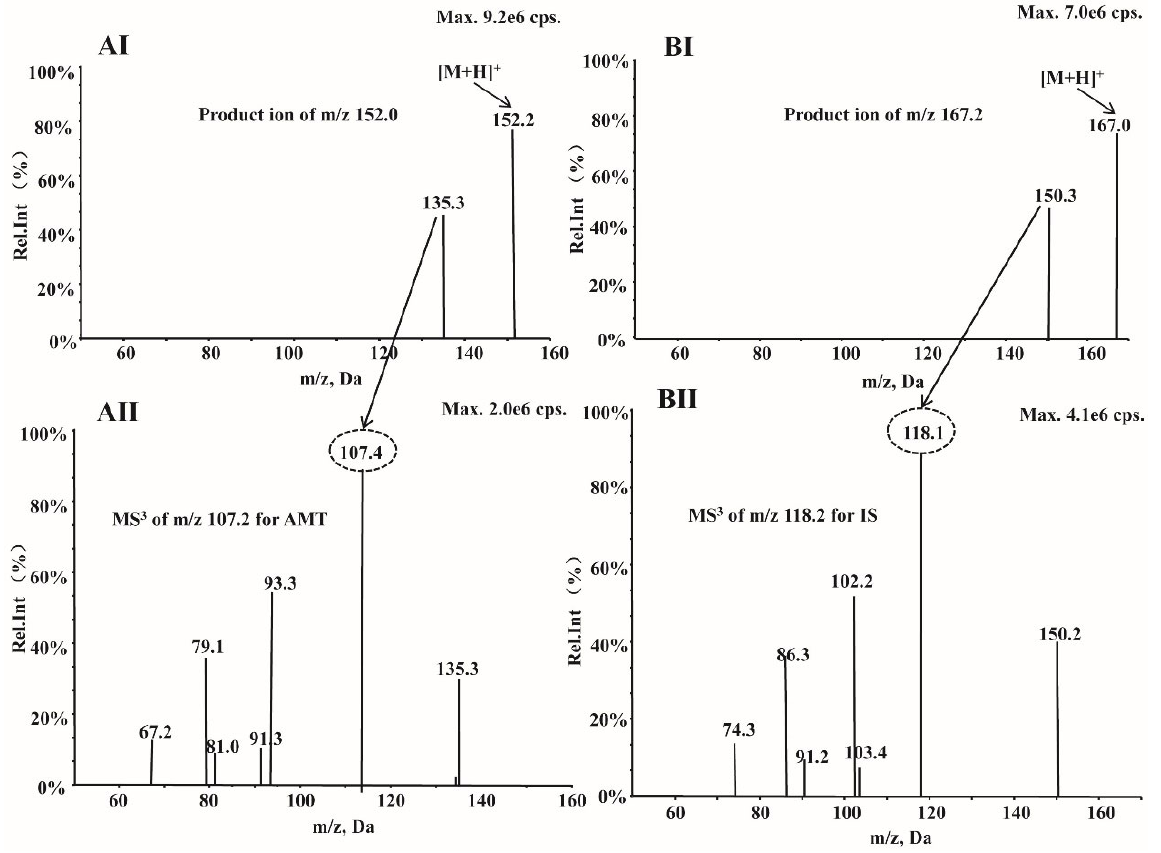
Figure 2. Product ion (MS 2 ) and second-generation product ion (MS 3 ) scans, respectively, for ( AI ) and ( AII ) AMT and ( BI ) and ( BII ) AMT-d 15 . Table 1. Optimized parameters for the quantitation of AMT using LC ‐ MS 3 .